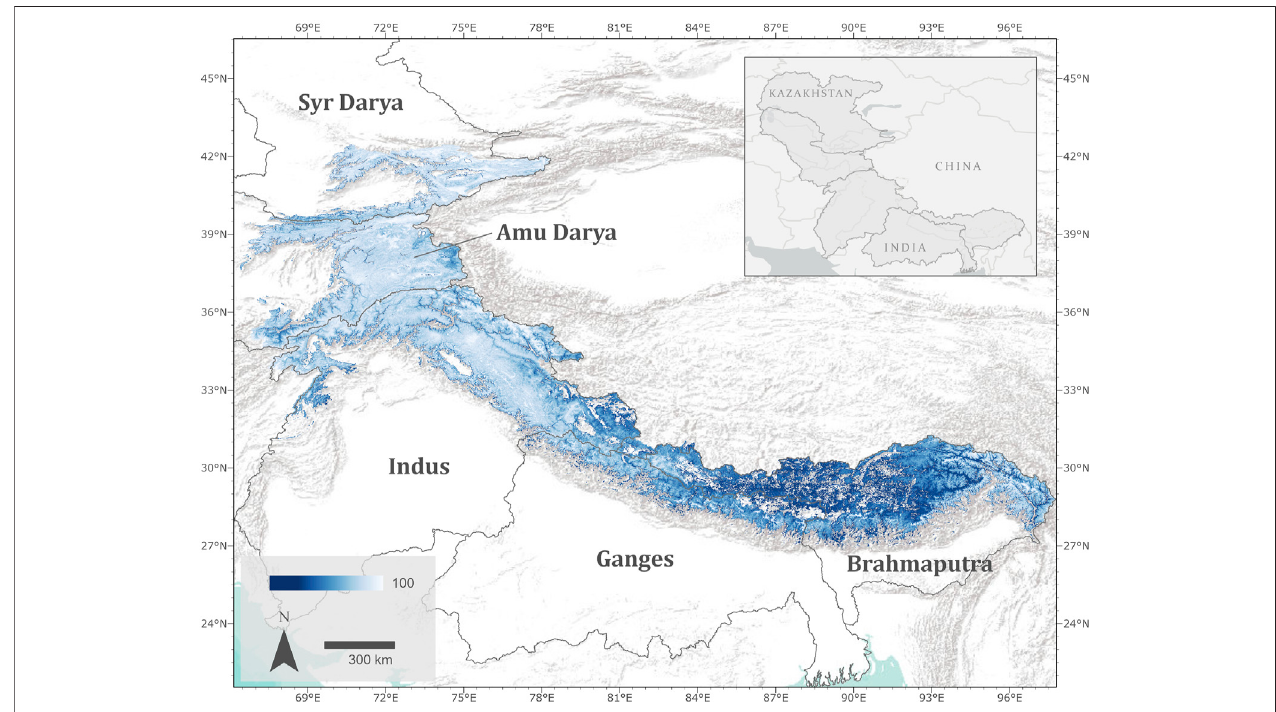
FIGURE 1 | The study area includes the following river basins: Syr Darya, Amu Darya, Indus, Ganges, and Brahmaputra. Using MODSCAG-STC, mean annual fractional snow-covered area is shown across each basin for the year 2017. The SCA value of 100, represented by the color white, indicates full snow coverage for a given pixel. Sources for the basemap include ESRI, USGS, and